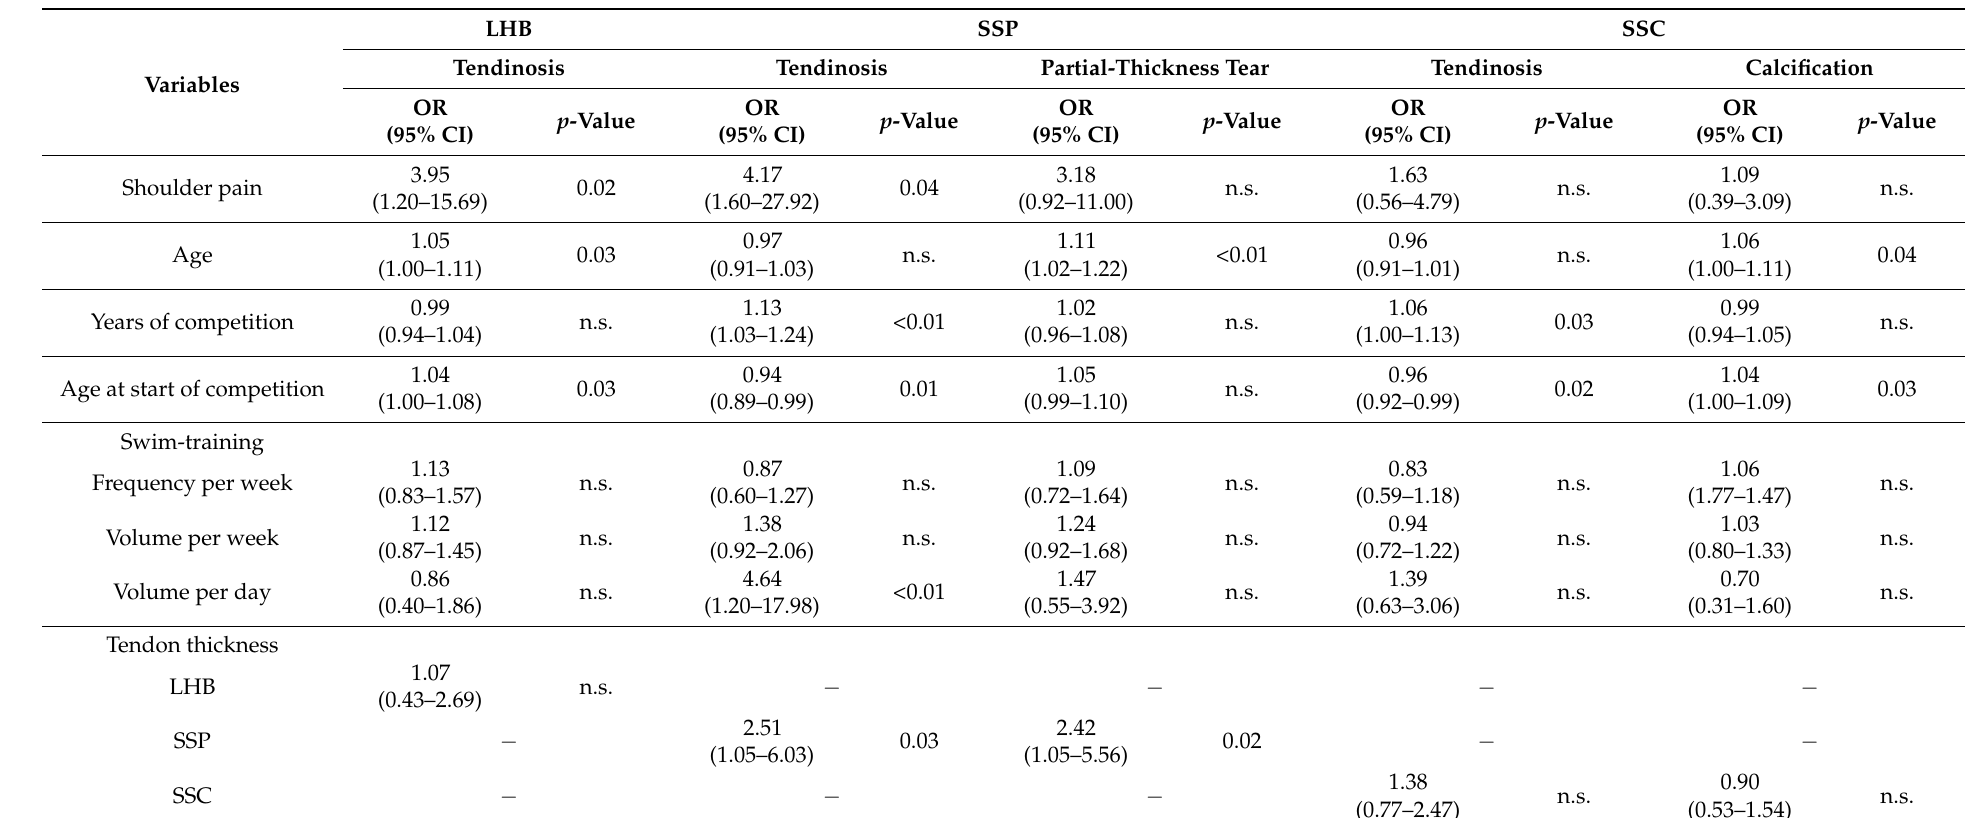
Table 3. Results from regression analysis for factors associated with ultrasonographic